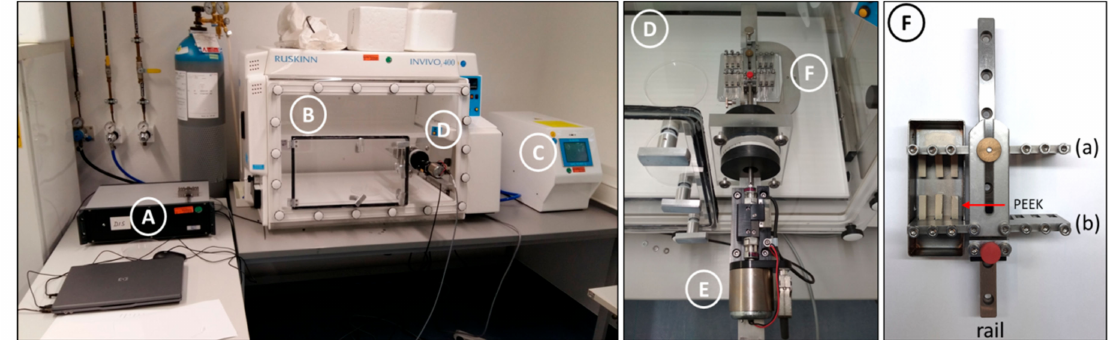
Figure 1. In-house built setup for the mechanical stretch of nerve explants. ( A ) The controller is connected to GalilTools software and the oscillator ( D , E ). ( B ) The incubator chamber keeping constant culture conditions. ( C ) The gas mixer analyzing the air constitution of the incubator chamber, 5% CO 2 . ( D ) The bioreactor ( F ) is mounted on the oscillator ( E ). ( E ) The oscillator is connected to the controller ( A ) and the bioreactor ( F ) inside the incubator. ( F ) Bioreactor. Two metal plates ( a and b ) are built on a metal rail, and poly-ether-ether-ketone (PEEK) bars are fixed on them by screws and kept in a metal boat filled with culture medium. Metal plate b is connected to the oscillator, moving back and forth, while the other plate is fixed to the stage and the metal